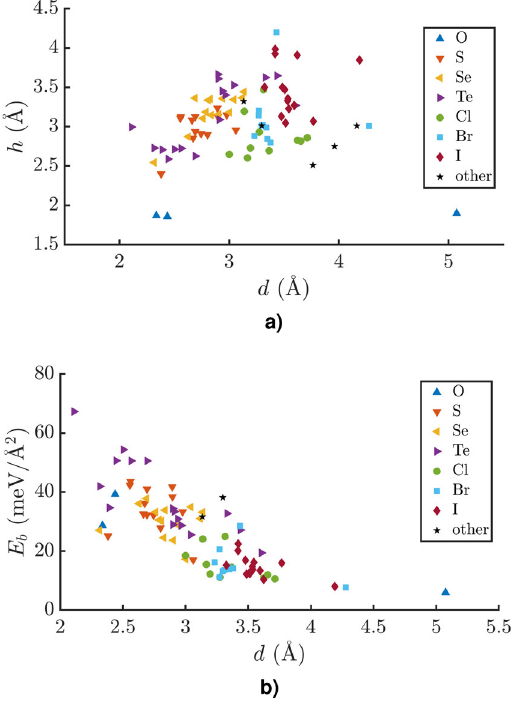
Fig. 2 Binding properties of the 2D compounds used as building blocks for constructing the vdWHs. a layer ’ s thickness, h , against the inter-layer distance, d . b the binding energy, E b , against the inter- layer